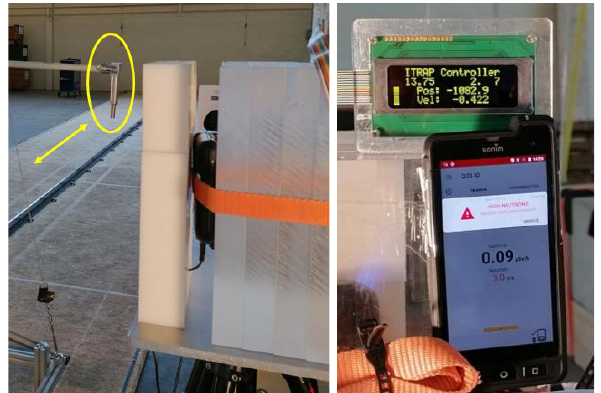
Fig. 7. Left: 252 Cf source marked by yellow ellipse is moved. The detector part of the D3S is fixed to the phantom. HDPE is placed in front. Right: The display part of the D3S next to the control display.